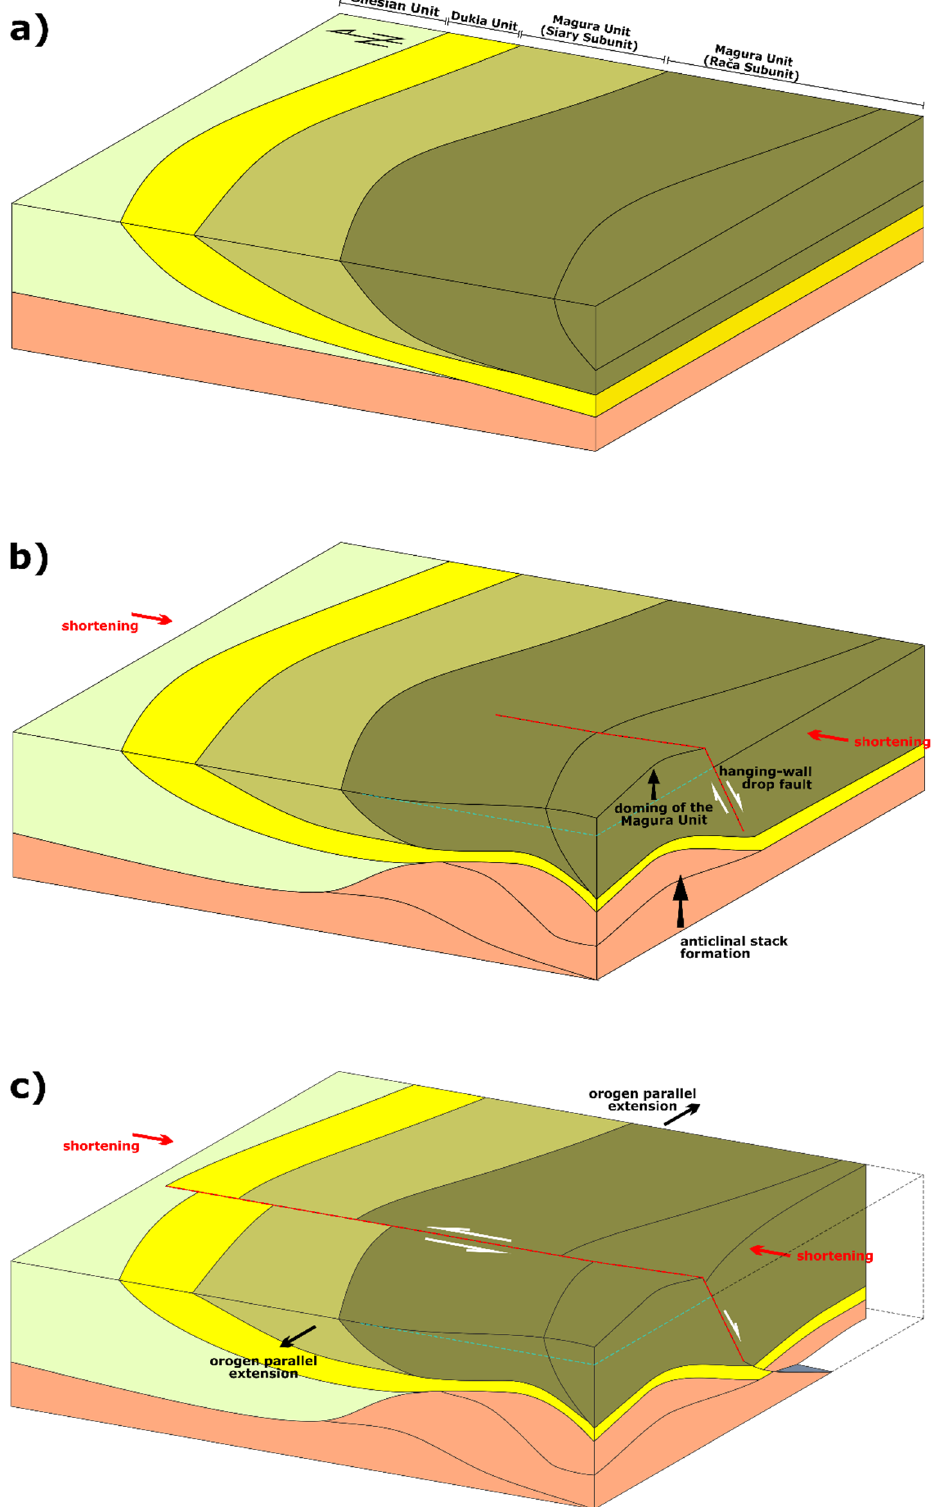
Figure 16. Cartoon showing the anticipated mechanism of the Rycerka Fault formation marked with a black-red dashed line (not in scale). ( a ) Pre-faulting situation. ( b ) Anticlinal stacking within the Dukla Unit and hanging-wall drop fault formation. ( c ) re-shaping of the Rycerka Fault in sinistral, transtensional settings related to orogen parallel extension. Colour coding as in previous figures. White arrows indicate movement along the Rycerka Fault. See the text for more explanation.